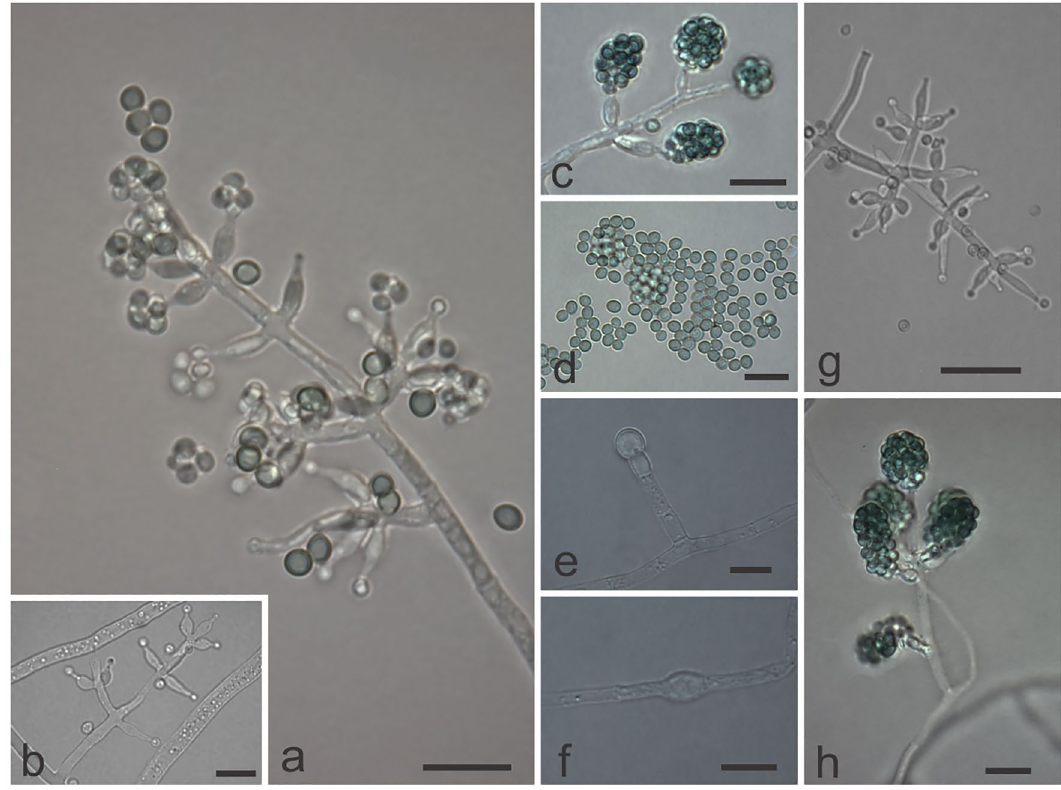
Figure 9. Morphological features characteristic of Trichoderma botryosum sp. nov. (COAD 2422). ( a , b , g ) Conidiophores and phialides formed on SNA. ( c , h ) Conidia grouped in bunches. ( e , f ) Chlamydospores on CMD. ( d ) Conidia. Bars: ( a – f , h ) = 10 µm; ( g ) = 20